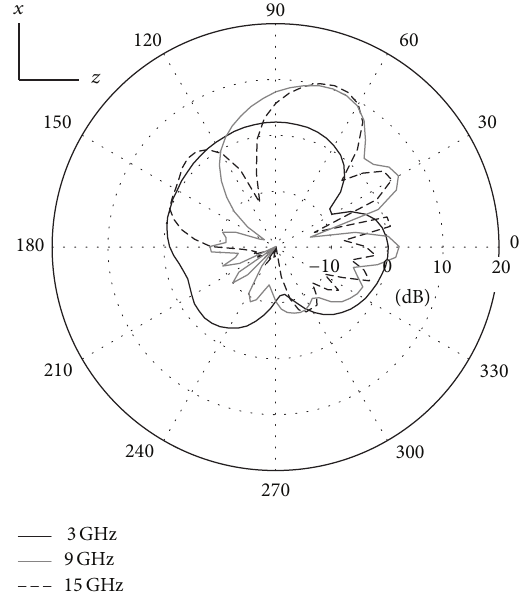
Figure 18: Radiation pattern of a semiplanar conical antenna with elliptical aperture and reflector in the xz plane.